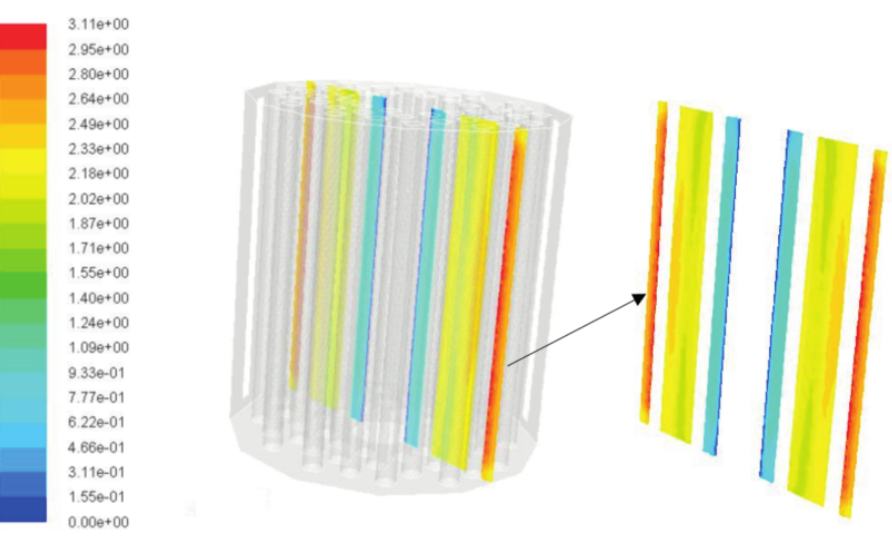
Figure 9: Pressure profiles in the mSOFC stack